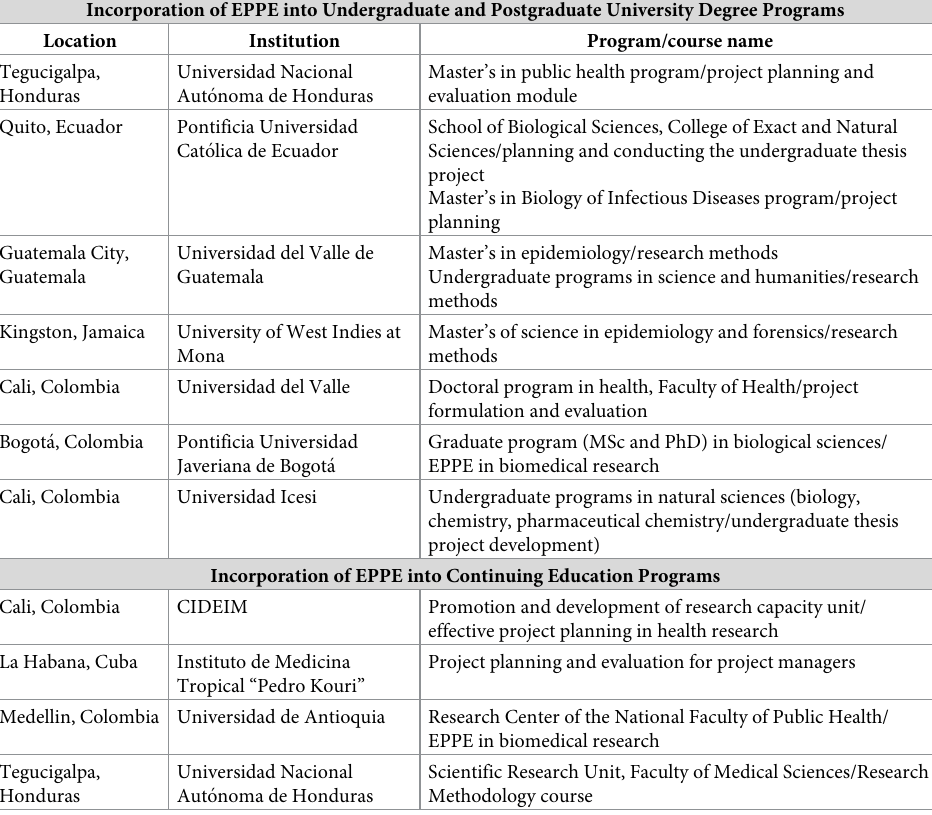
Table 1. Institutionalization of EPPE